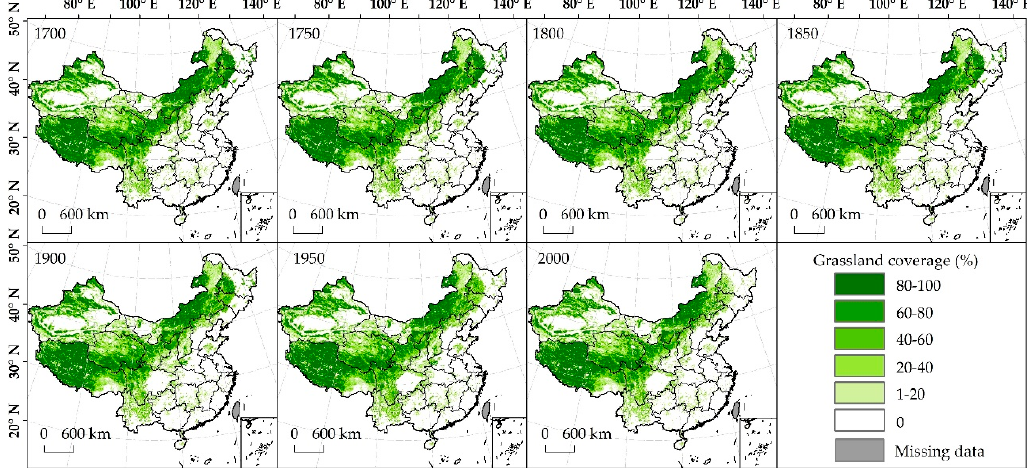
Figure 5. Spatial distribution of grassland cover in China from 1700 to 2000.